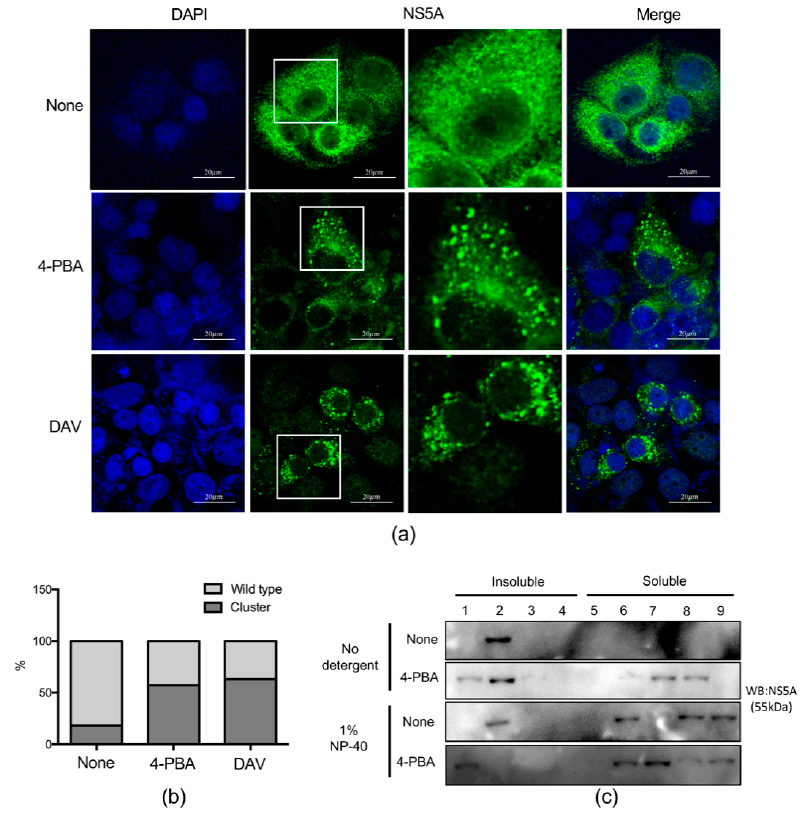
Figure 6. 4-PBA altered membranous web formation. ( a ) Huh7.5-Con1 cells were treated with 4-PBA for 24 h, and NS5A (green) was detected by immunolabeling, with DAPI (blue) nuclear counterstaining. Scale bar = 20 µm ( b ) Immunolabeled NS5A cluster structures were detected using the particle analysis function of ImageJ software. Data are expressed as means ± SDs of five independent experiments. ( c ) Cells were harvested 24 h after treatment with 1 mM 4-PBA, and cell lysates were incubated on ice in the presence or absence of 1% NP-40 for 1 h and fractionated on a sucrose gradient. Each fraction was concentrated with trichloroacetic acid and analyzed by SDS-PAGE. NS5A was detected